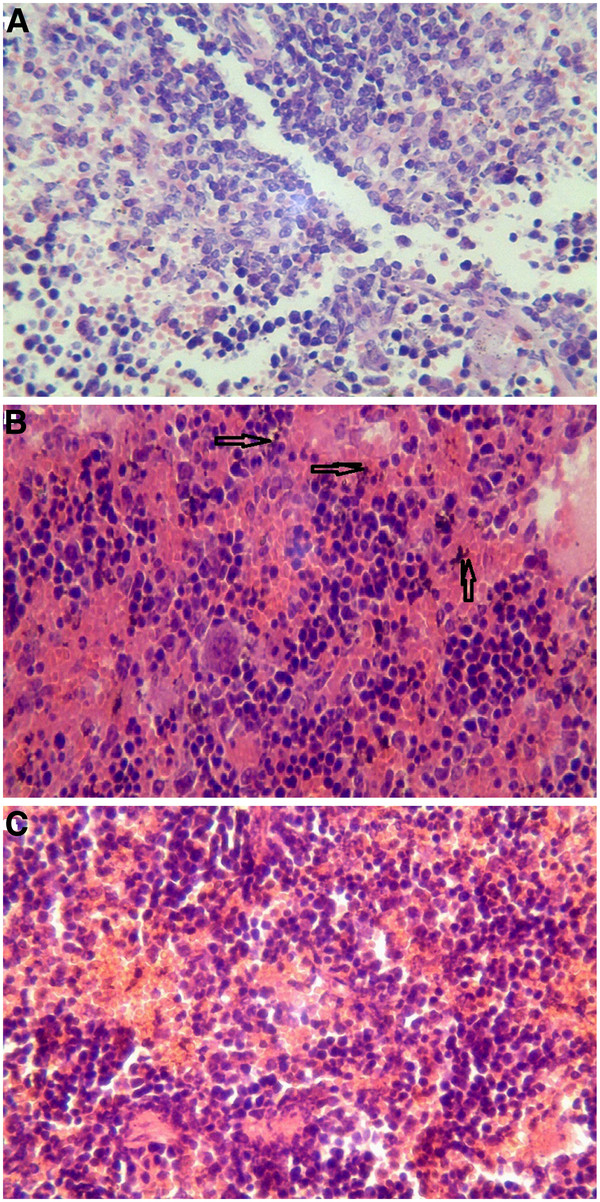
The histology of spleen tissues (×20). (A) oMWCNTs, (B) NDs, and (C) oMWCNTs + NDs.